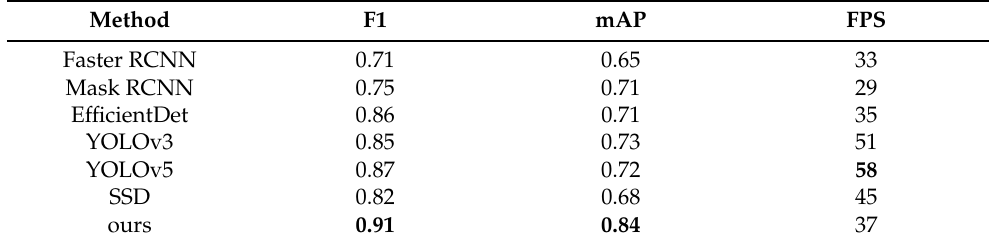
Table 4. Comparison of two-stage, YOLO series, EfficientDet, SSD detection models, and ours. Method F1 mAP FPS Faster RCNN 0.71 0.65 33 Mask RCNN 0.75 EfficientDet